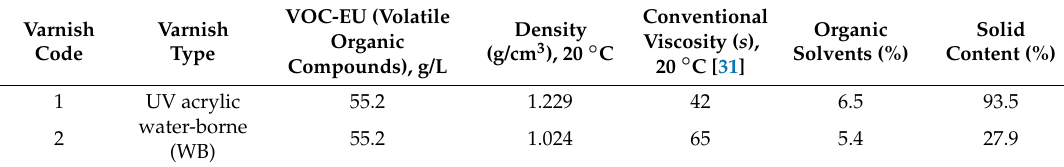
Table 2. Parameters of the coating